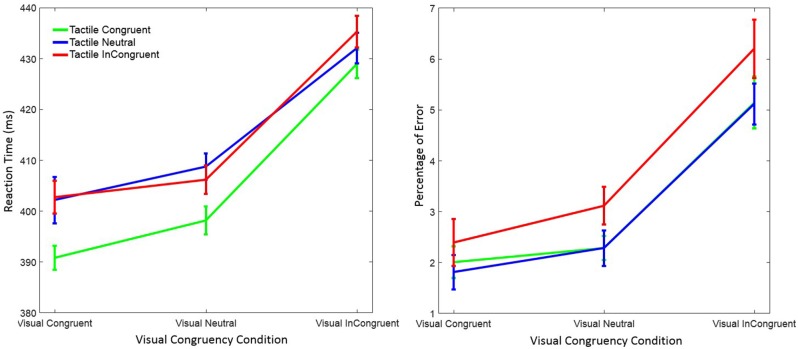
Mean reaction time (left figure) and mean percentage of response errors (right figure) in Experiment 1 as a function of visual and tactile congruency. Error bars were computed according to Morey's method (Morey, 2008).